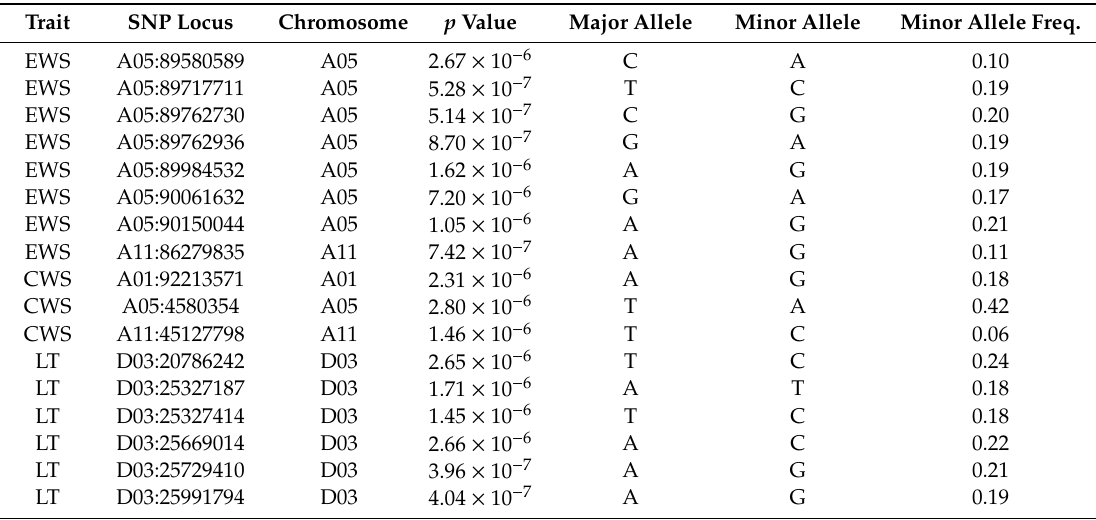
Table 1. Summary of loci associated with drought tolerance traits identified by a GWAS in upland cotton. Trait SNP